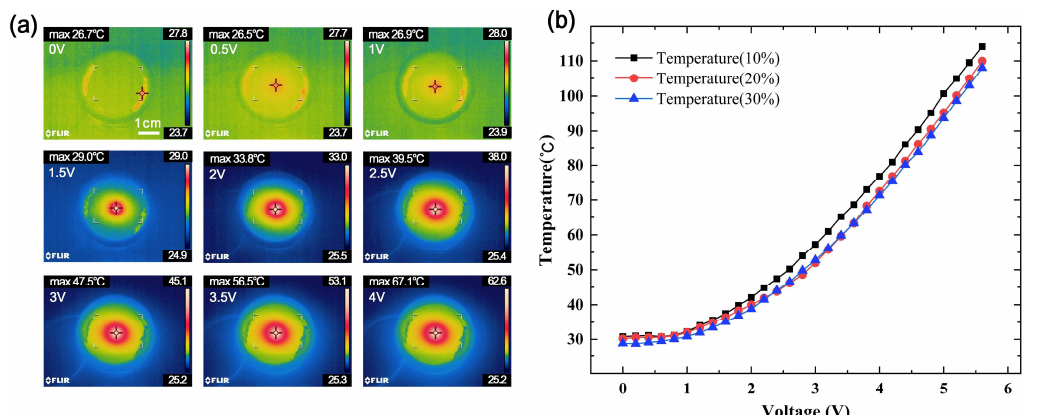
Figure 3. ( a ) Infrared thermal images of film surfaces under different voltages. ( b ) Variation curve of film center temperature with voltage.